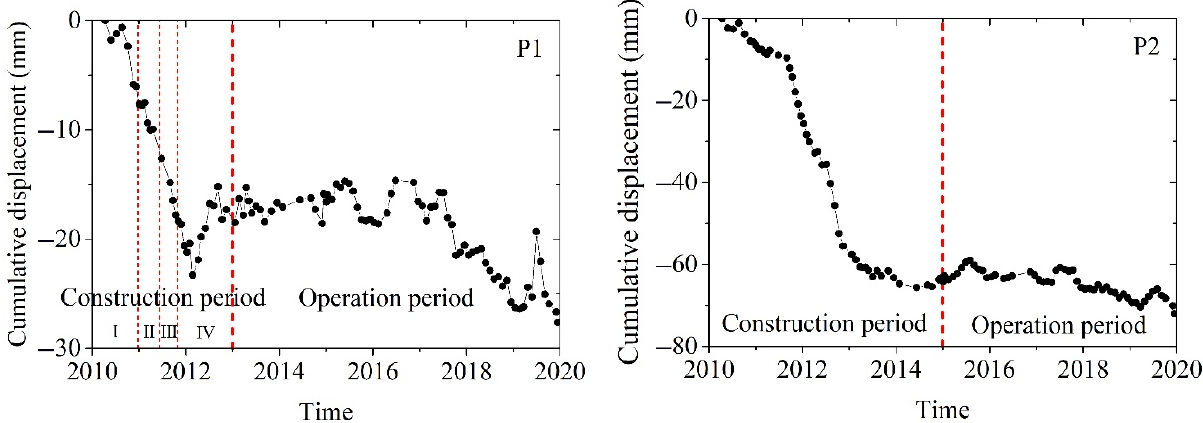
Figure 12. Time series displacement of P1 and P2. Ⅰ : small pilot tunnel construction stage; Ⅱ : beam and column construction stage; Ⅲ : arch buckle construction stage; Ⅳ : earth excavation and main structure construction stage. Table 4. Properties of the subway lines in the study area.